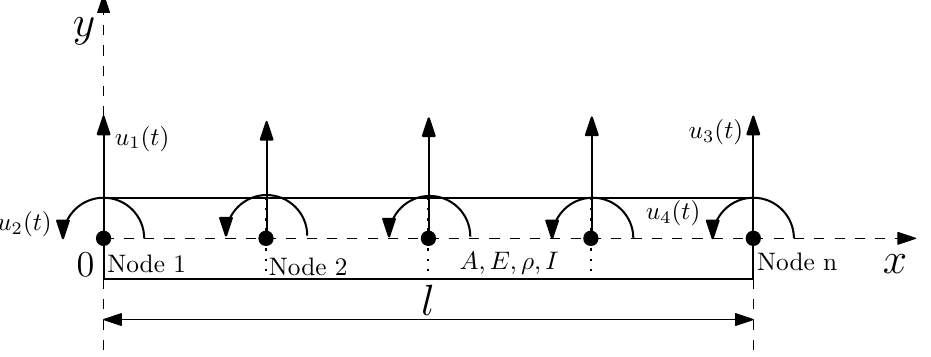
Figure 1. Euler–Bernoulli beam